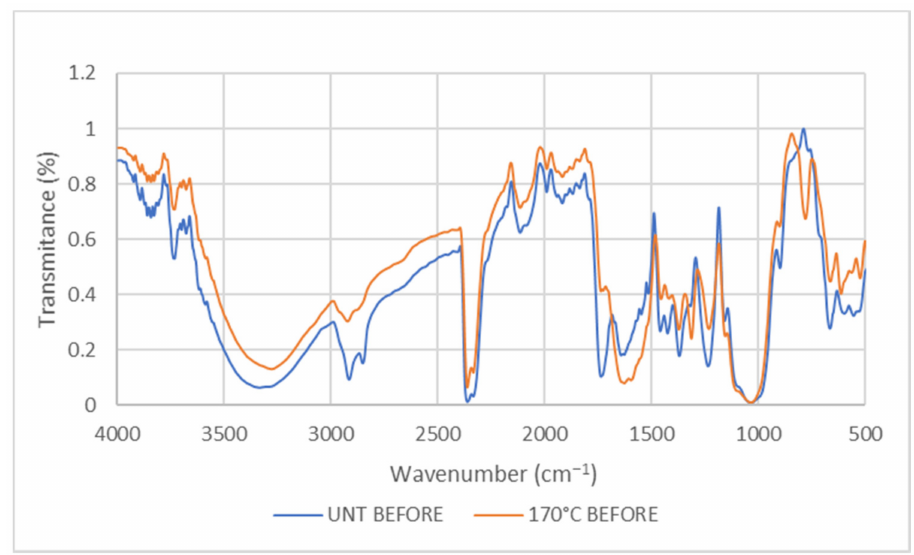
Figure 2. Comparison of IR spectra between EFB untreated and treated with 170 ◦ C samples before wetting with oil. UNT: Untreated.